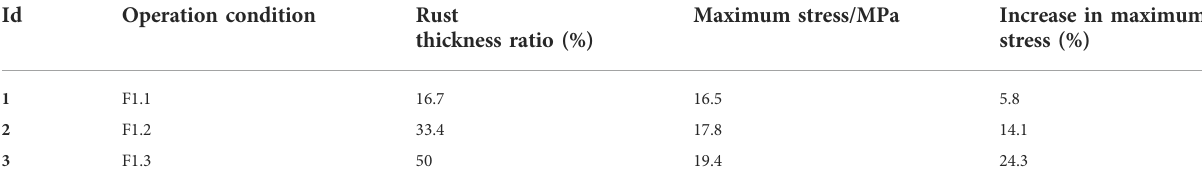
TABLE 3 Results of fi nite element stress analysis of corrosion tower under self-weight